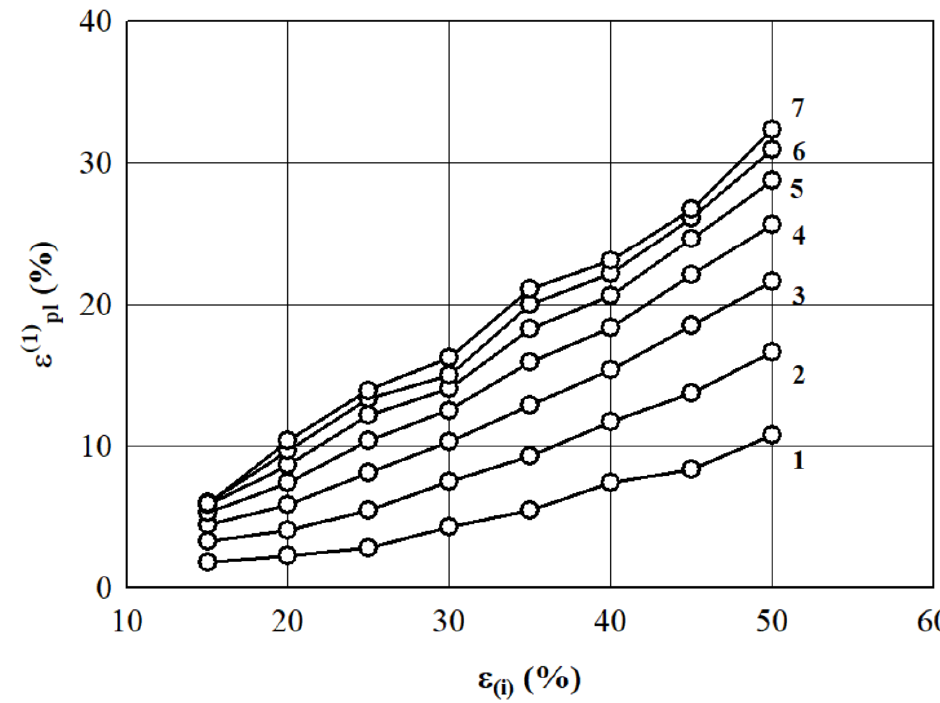
Figure 5. The dependence of the prognostic point values of residual (plastic) strain ε pl (calculated according to Equation (2)) on the value of active fixed deformation ε i when EPS density is 1–10 kg/m 3 ; 2–15 kg/m 3 ; 3–20 kg/m 3 ; 4–25 kg/m 3 ; 5–30 kg/m 3 ; 6–35 kg/m 3 , and 7–40 kg/m 3 .